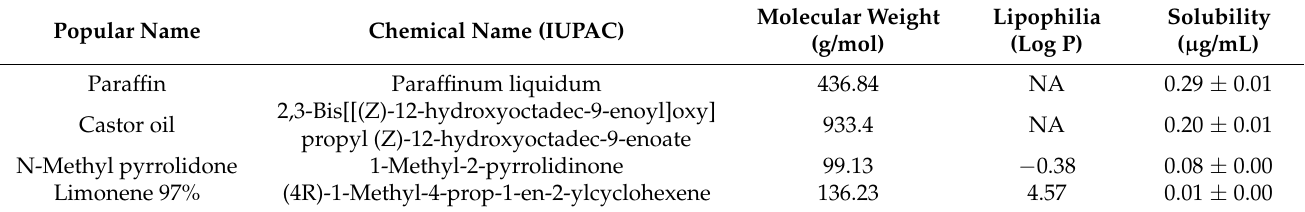
Table 3. Solubility of BCT in the oils and enhancers tested using fluorescence spectroscopy. Results are reported from the highest to the lower solubility of BCT in the